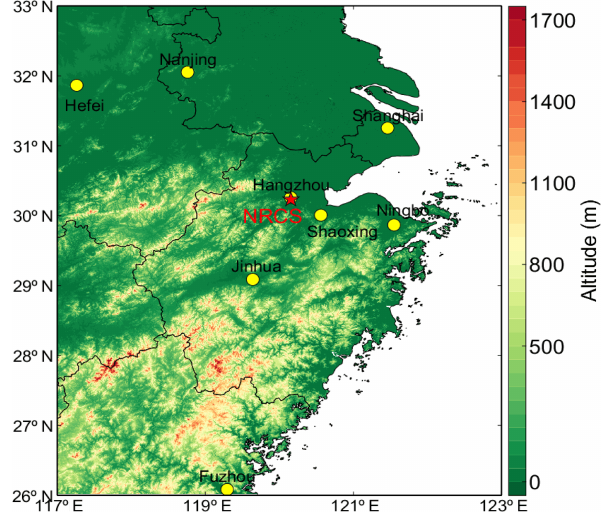
Figure 1. The topography of the National Reference Climatological Station (NRCS) (30.22 ◦ N, 120.17 ◦ E, 41.7ma.s.l) in Hangzhou, China. The star represents the location of the